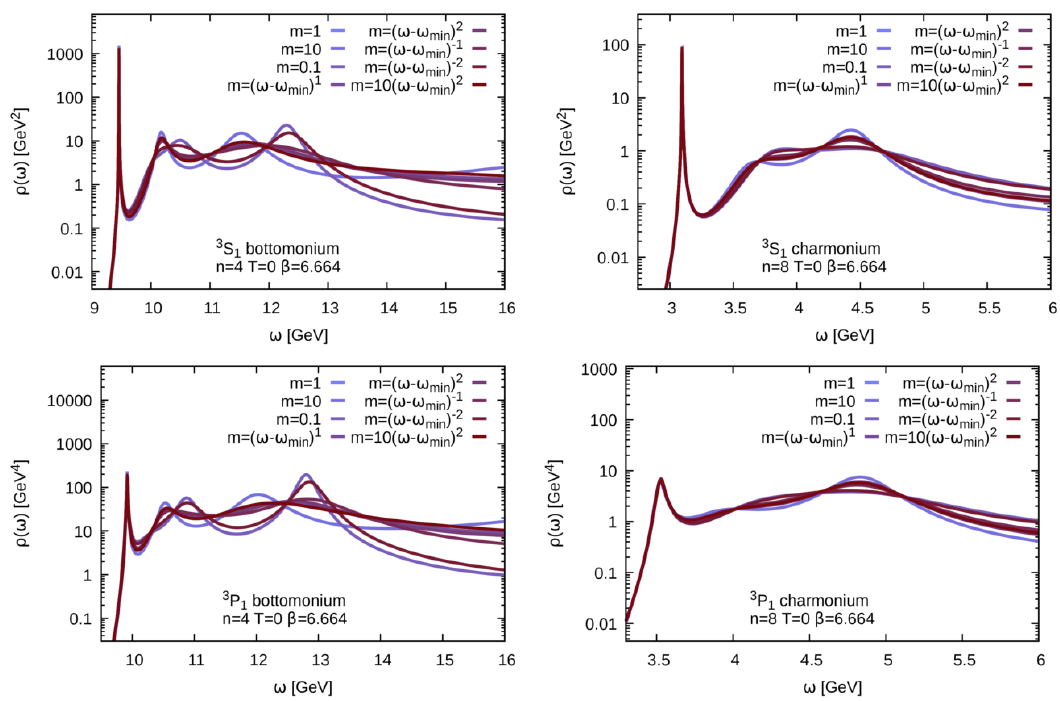
Figure 44 . Representative examples of the default model dependence of the spectral reconstruc- tions at zero temperature ( (cid:12) = 6 : 664). Bottomonium results given on the left, charmonium on the right. We depict the S-wave channel in the top row, the P-wave channel in the bottom row.